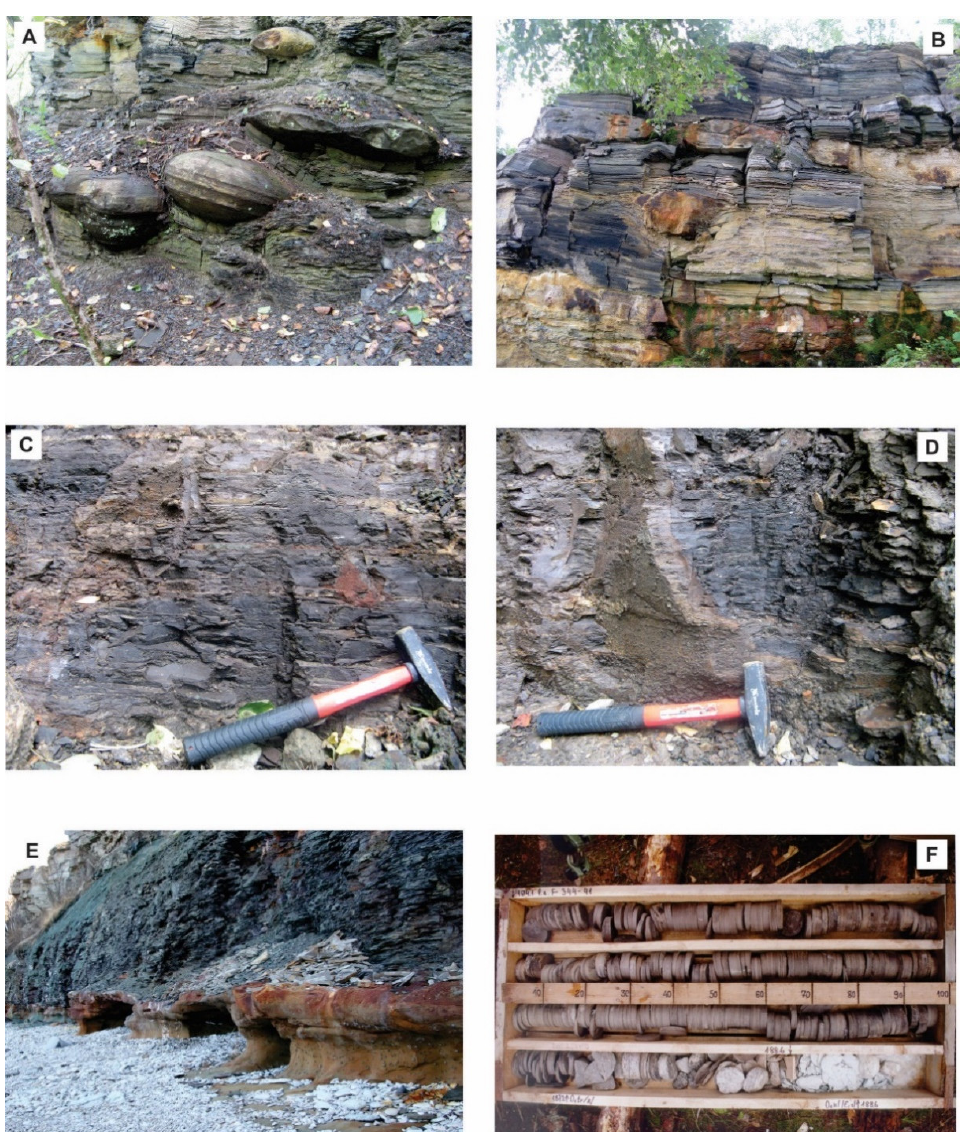
Figure 2. Representative outcrop and drill core photographs of the studied black shale. ( A , B ) Out- crops in Billingen and Kinnekulle, Sweden; ( C , D ) outcrops in western Russia; ( E , F ) outcrop in the Pakri Peninsula (NE Estonia) and drill core F344 (W Estonia), respectively.